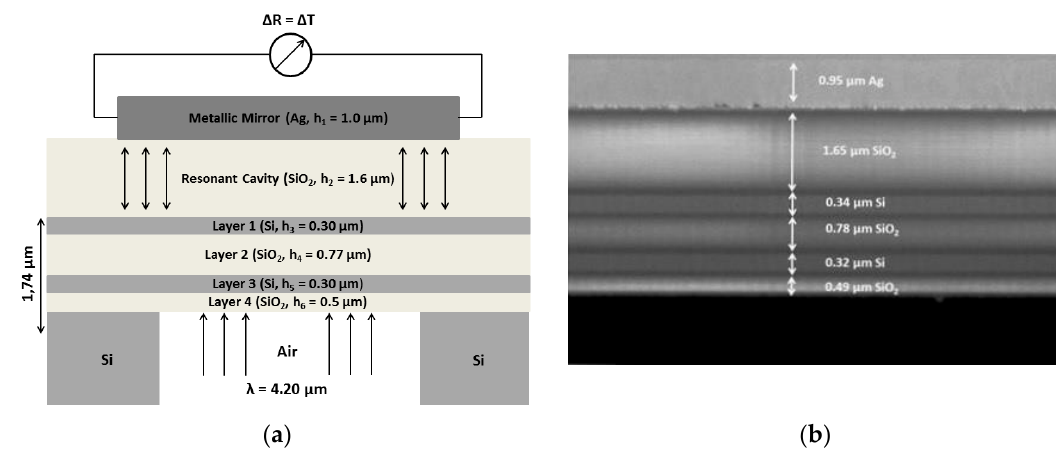
Figure 1. Schematic of the VERD structure ( a ) and an example FIB cross section through the fabricated device indicating the individual layer thicknesses ( b